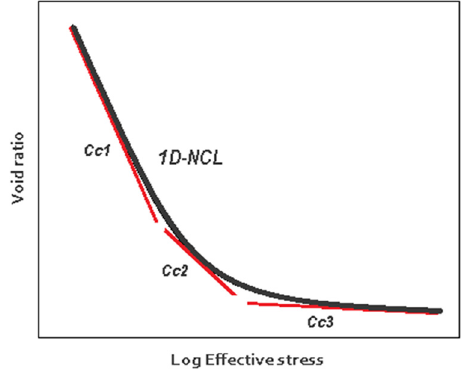
Figure 2: The proposed complete 1D - NCL with three slopes C c1 , C c2 , and C c3